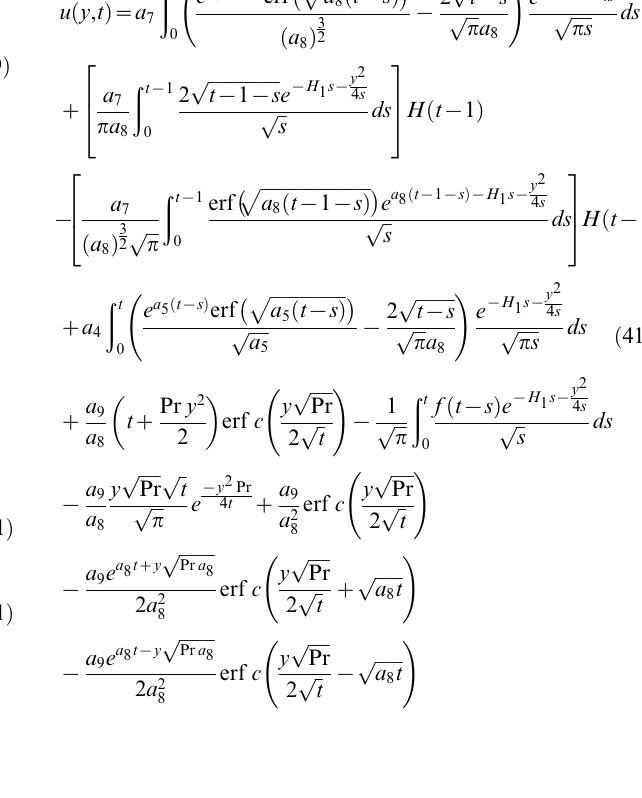
p 2 ffiffiffiffiffiffiffiffiffiffiffiffiffiffiffiffi t { 1 { s